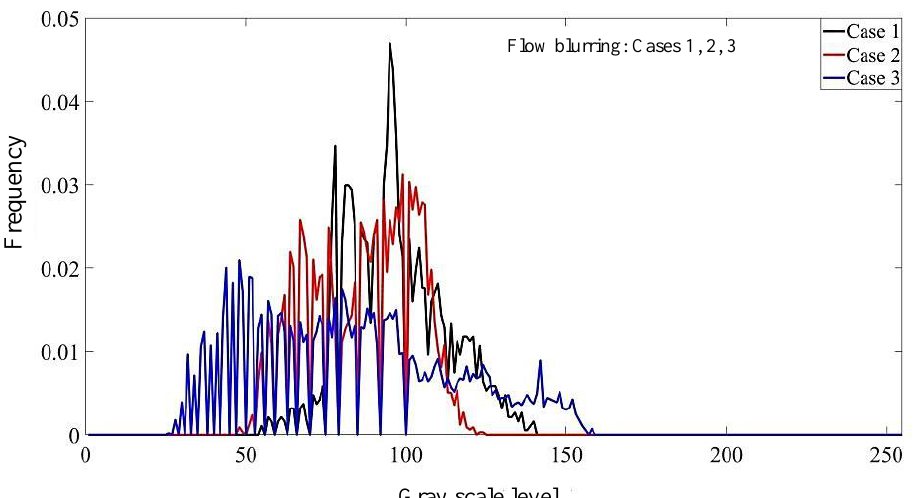
Figure 13. The gray distribution curves of the two-phase flow images under different air flow rate and orifice diameter: the water flow rate and tube hole distance are 100 mL/min and 1 mm. Based on case 1, the air flow rate and orifice diameter in cases 1 to 3 can be dimensionless into (In the form of air flow rate/orifice diameter):1/1, 1.5/1.66 and 2/2.33.